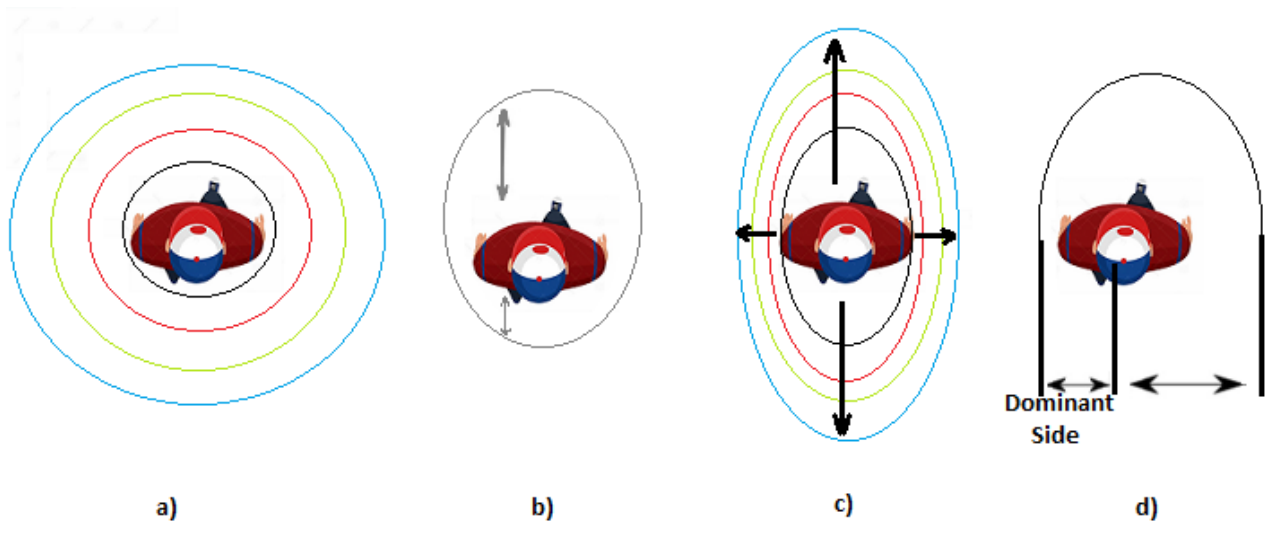
Figure 3. Different shapes of proxemic zones: ( a ) the classical four proxemic zones of Hall’s theory; ( b ) the personal space refers to the “private sphere” in the Social Force model; ( c ) proxemic zones as concentric ellipses; ( d ) proxemic zone is smaller on the dominant side of the pedestrian [22].